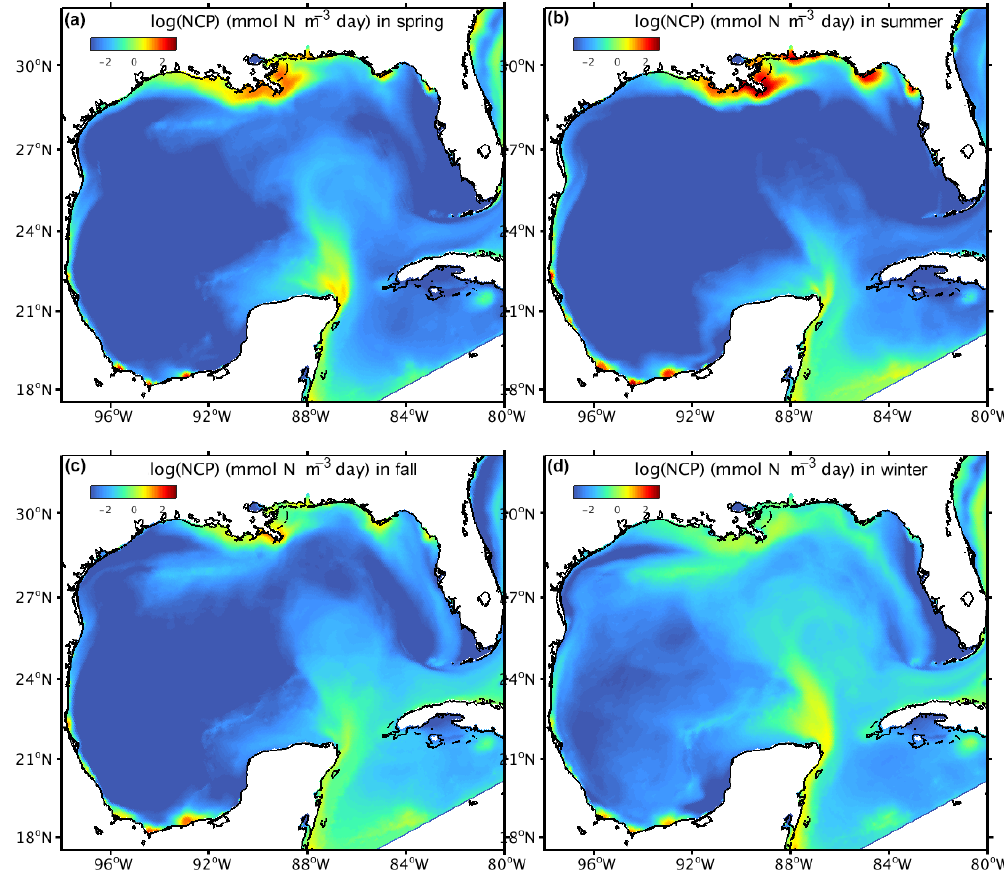
Figure 8. Six-year (2005–2010) model (control run) mean surface net community production (NCP) in the Gulf of Mexico during (a) spring, (b) summer, (c) fall, and (d)